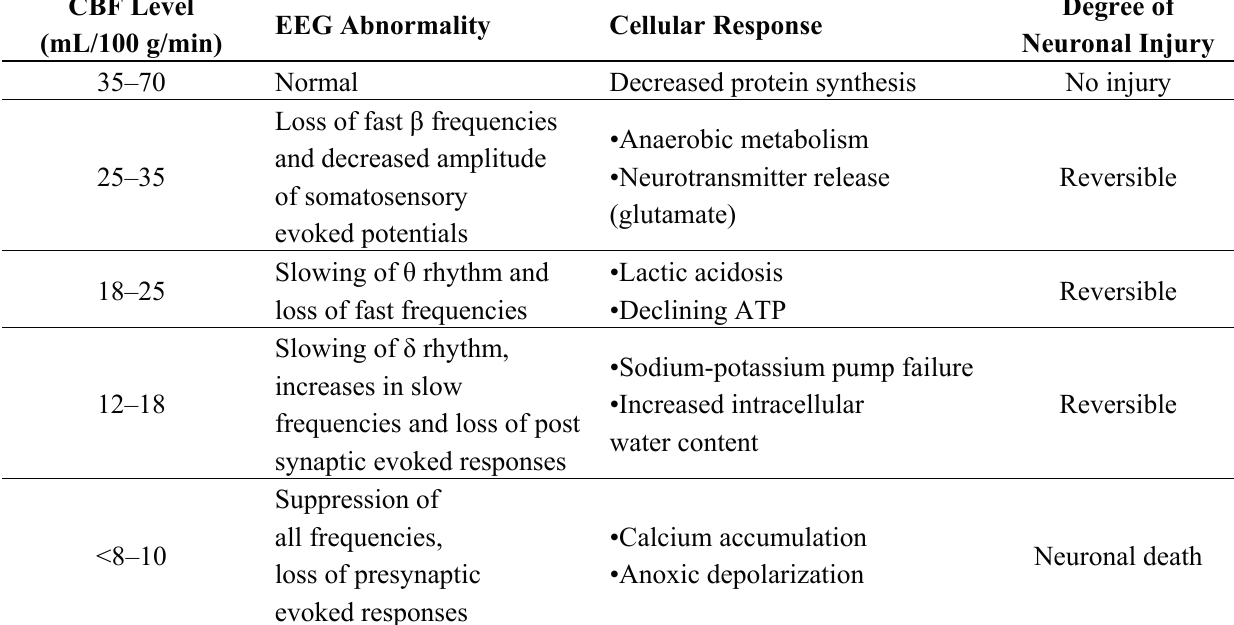
Table 1. Physiological coupling among cerebral metabolism, EEG, and cellular response, and the consequence on neuronal injury. EEG: electroencephalography, CBF: cerebral blood flow, ATP: adenosine